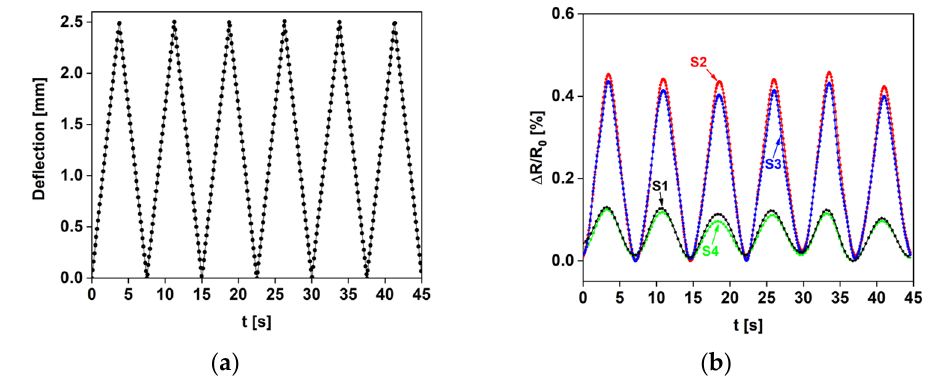
Figure 15. ( a ) Cyclic diagram of displacement impressed by the crosshead. ( b ) Normalized re-